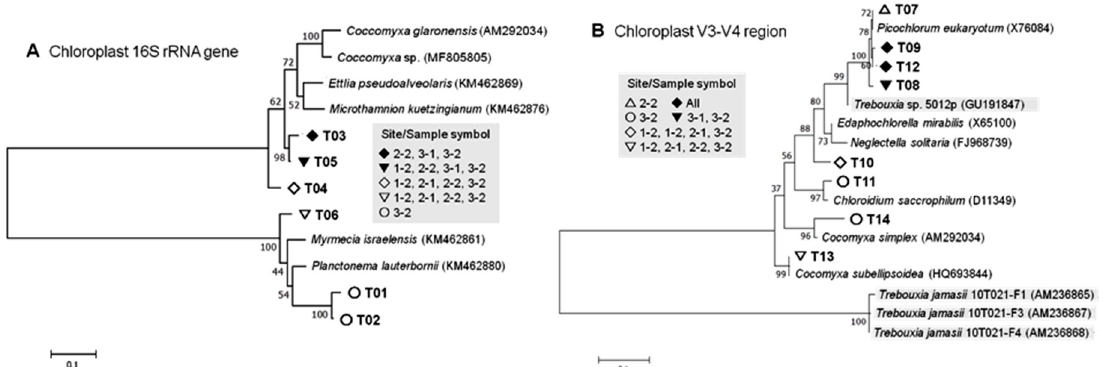
Figure 5. Phylogenetic trees of 16S rRNA genes ( A ) and V3-V4 regions ( B ) of the lichen-associated algae-derived and related chloroplast phylotypes (with accession numbers) generated by the Maximum Composite Likelihood method. The tree with the highest log likelihoods ( − 6819.36 and − 1396.40 for A and B, respectively) is shown. Four known Trebouxia -hosted chloroplast sequences are lightly shaded. The percentage of trees in which the associated taxa clustered together is shown next to the branches. The tree is drawn to scale, with branch lengths measured in the number of substitutions per site. Phylotype codes correspond to those shown in Table 4.